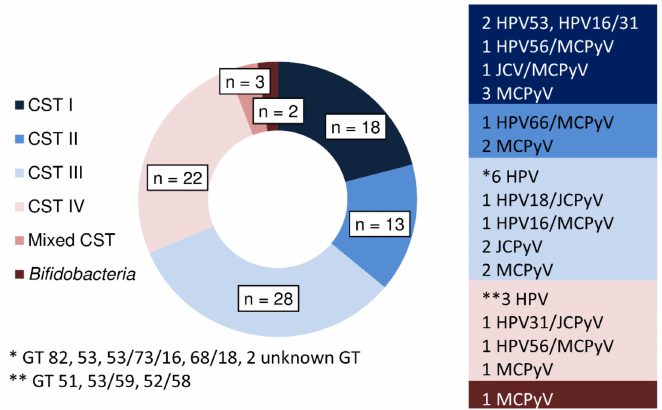
Figure 3. The CSTs distribution. The grouping of samples according to the vaginal community state types (CSTs) and the distribution of viruses within each CST. Abbreviations: GT: genotype; n = number of samples.